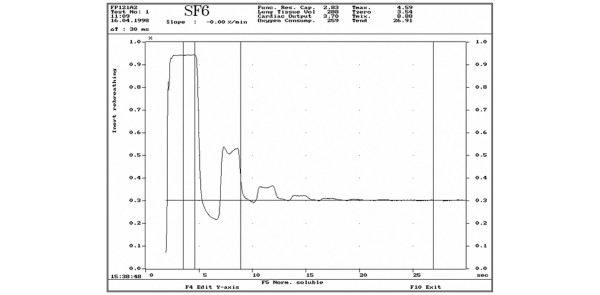
Concentration of the tracer gas sulphur hexafluoride (SF6) plotted during 30 s of rebreathing in a supine healthy subject.